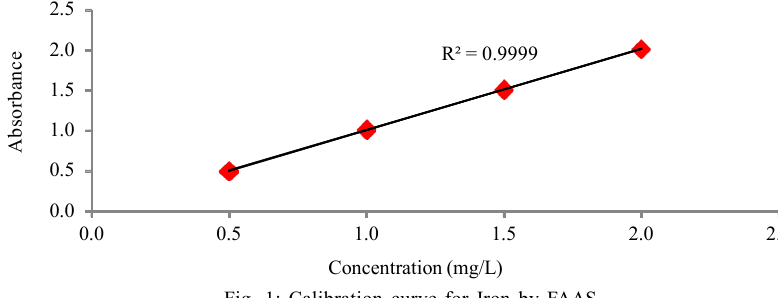
Fig. 1: Calibration curve for Iron by